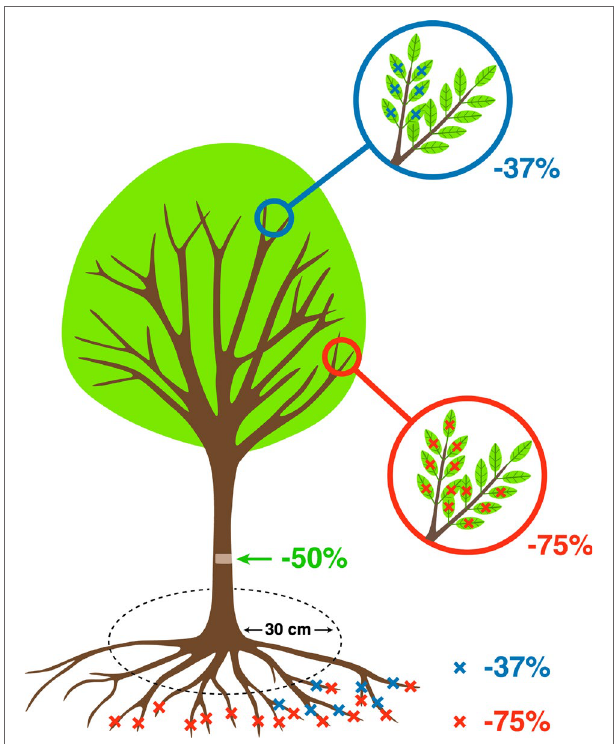
FIGURE 2 | Schematic representation of the treatments described in Table 1 (more details about stress treatments in Ramirez (2017).